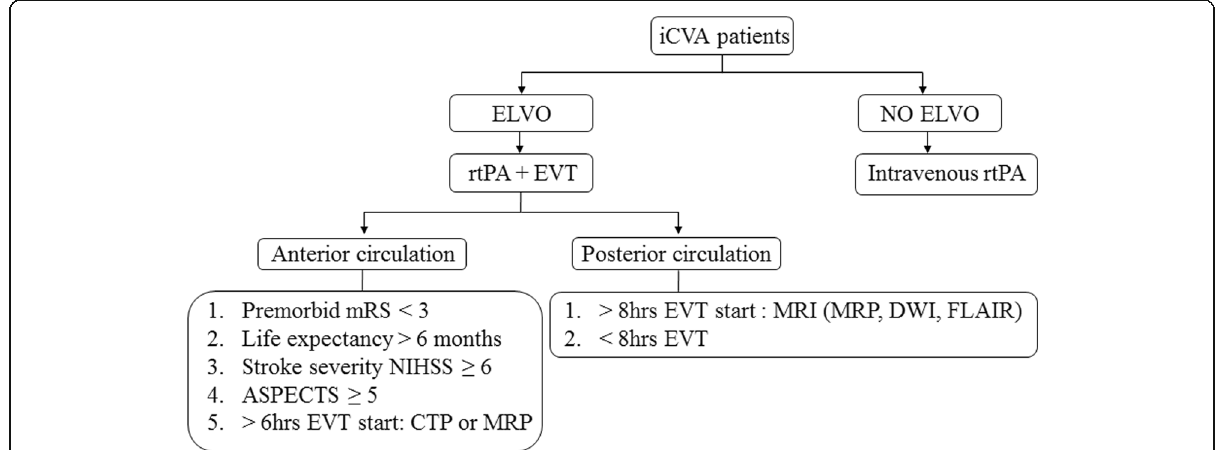
Fig. 1 Schematic overview of EVT selection guidelines used for anterior circulation stroke